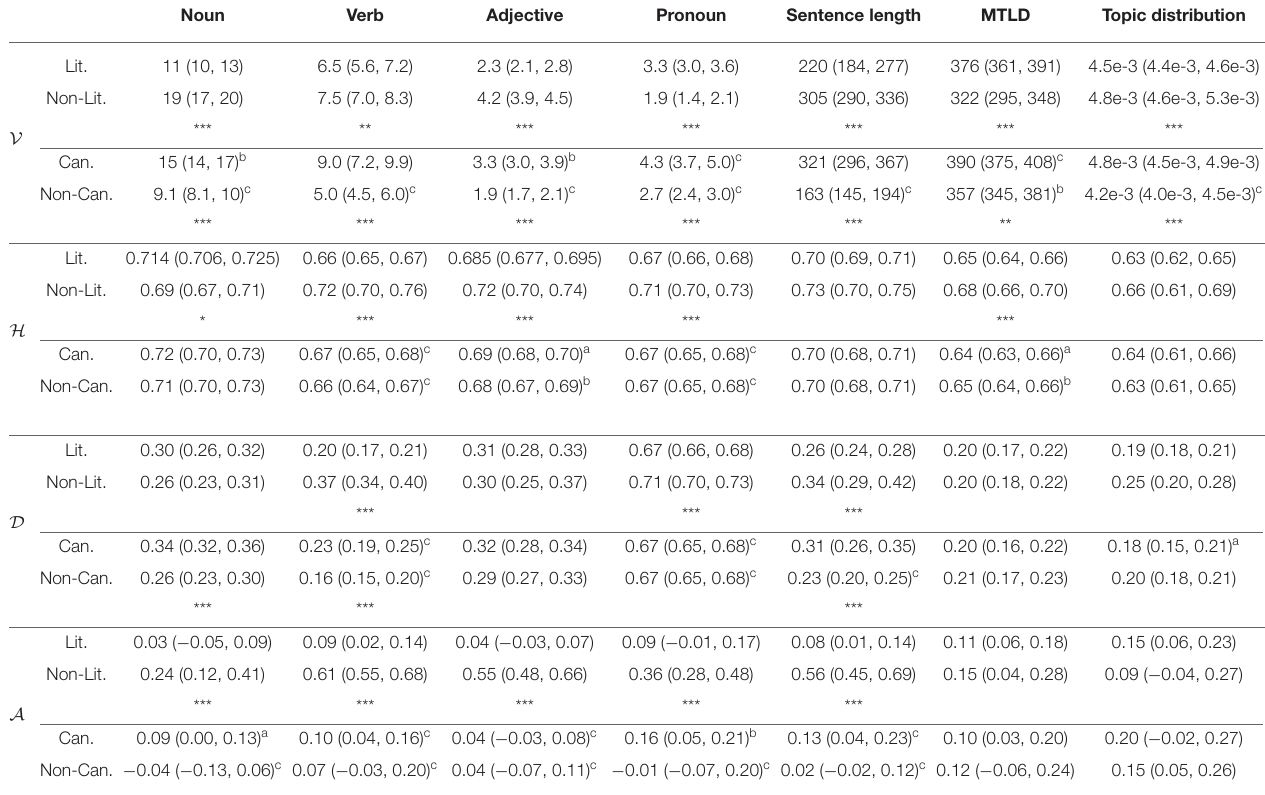
TABLE 2 | Median values of all text properties.